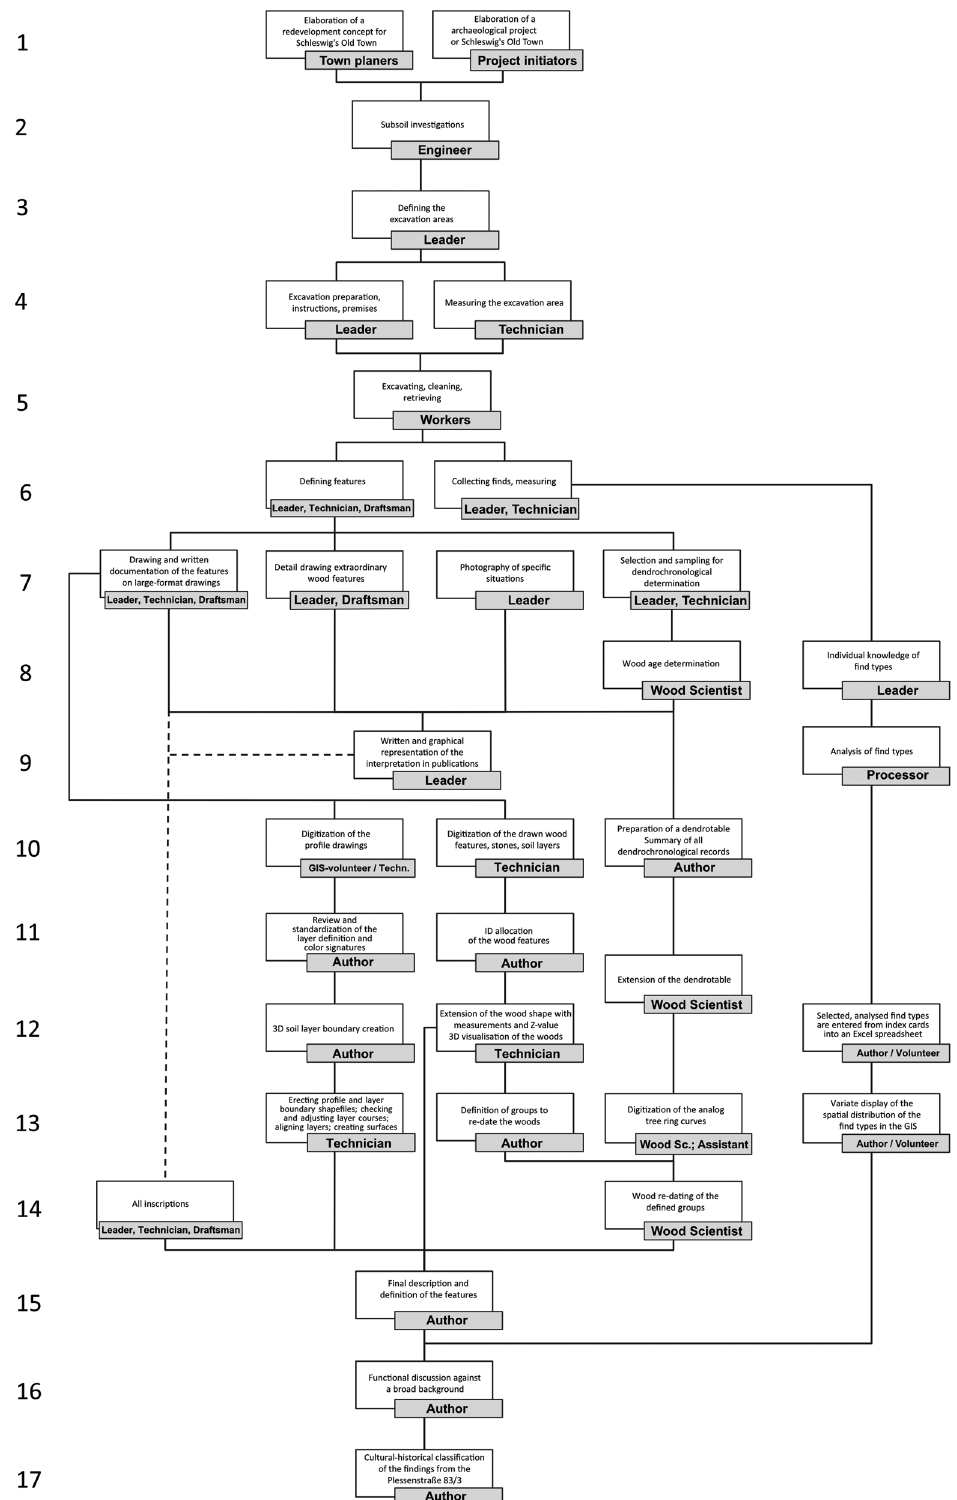
Figure 4: Chaîne opératoire depicting the steps in the production of archaeological knowledge from the analysis of the Plessenstraße 83/3 excavation ( Graphics: F. Rösch )